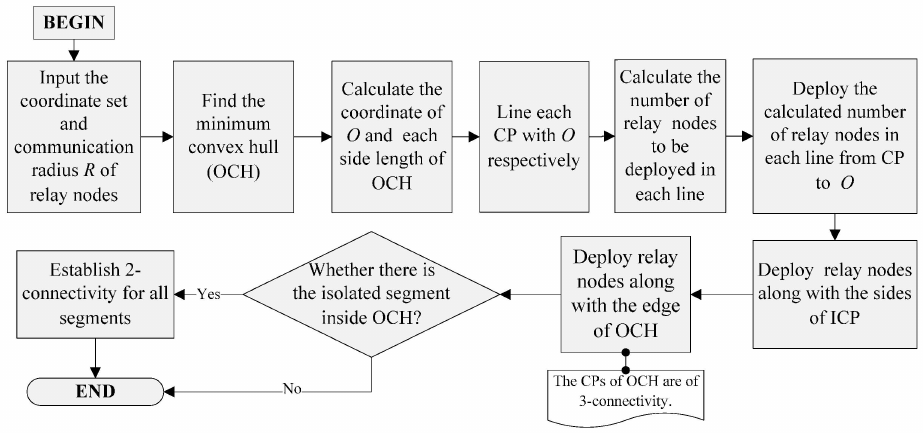
Figure 3. Flow chart of Partial 3-Connectivity Restoration